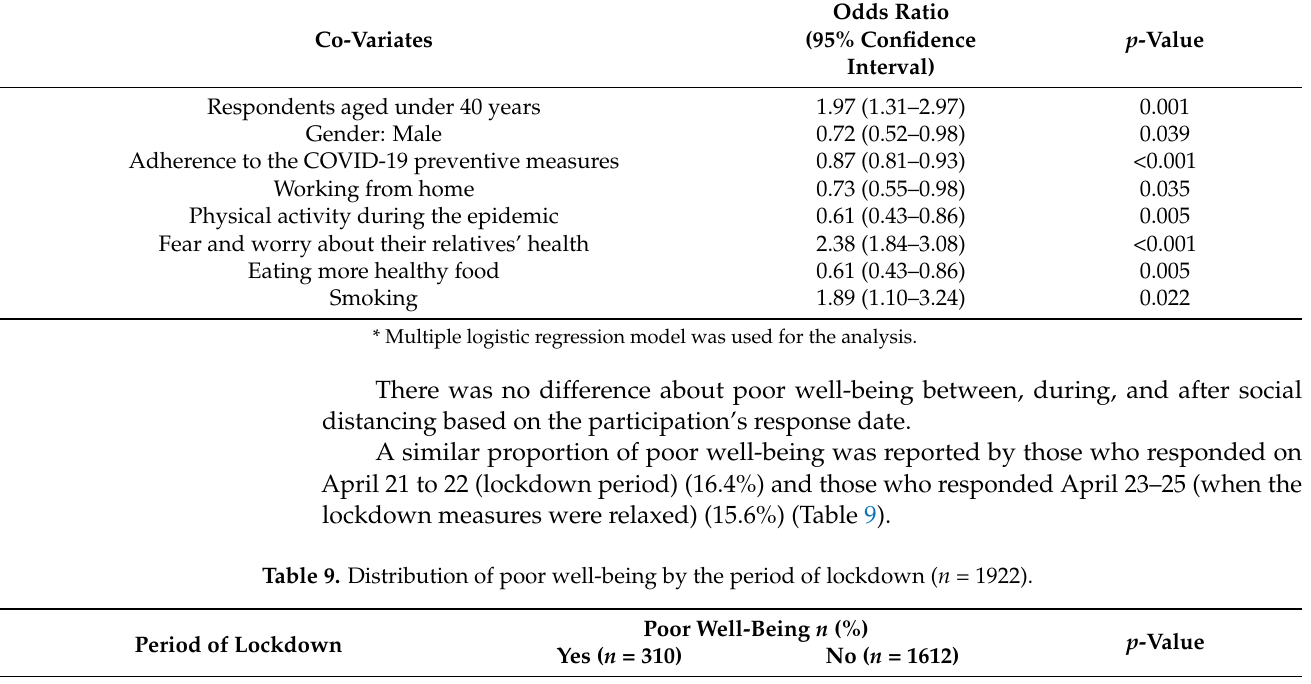
Table 8. Regression model investigating factors associated with poor well-being during the COVID-19 pandemic *. Co-Variates Respondents aged under 40 years